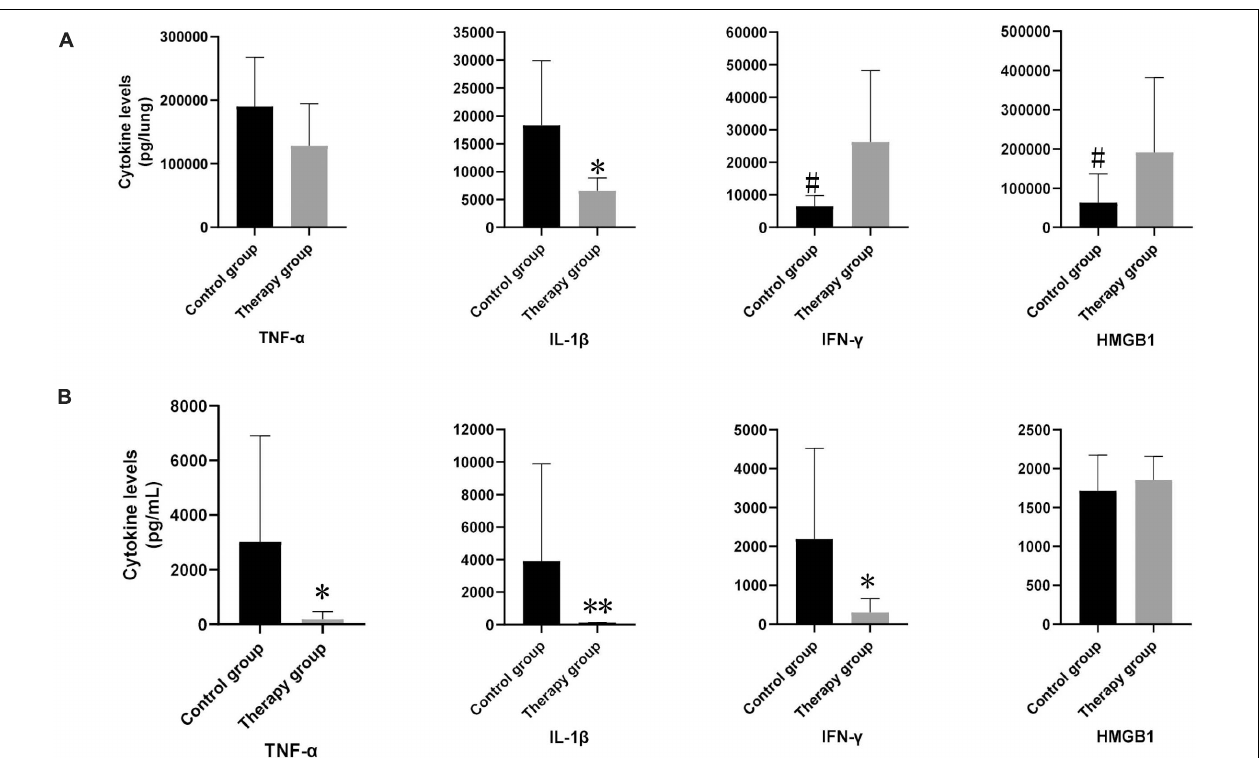
FIGURE 4 | The levels of inflammatory cytokines in mouse lungs and serum. In lung samples (A) , the levels of IL-1 β in phage-treated mice ( n = 6) were significantly lower than those in control mice ( n = 6). In serum samples (B) , the levels of TNF- α , IL-1 β and IFN- γ in phage-treated group were significantly lower than that of the control group, however, HMGB1 had no significant difference. Data are presented as mean ± SEM of two experiments (* < 0.05, ** < 0.01 vs. untreated control).